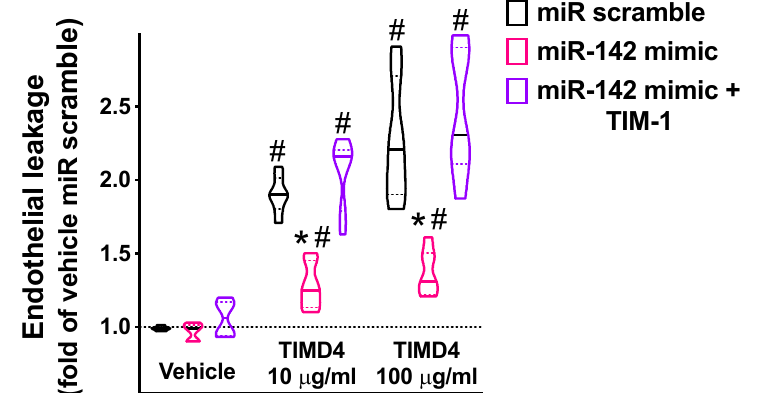
Figure 5. The targeting of TIM ‐ 1 by miR ‐ 142 significantly reduced endothelial permeability. Endothelial leakage triggered by 48 h incubation with TIM ‐ 1 agonist TIMD4 (10 or 100 ng/mL; BioLegend San Diego, CA, USA) was measured in hBMECs transfected with miR ‐ 142 mimic, miR scramble, or by combining miR ‐ 142 mimic and TIM ‐ 1 overexpression ( pcDNA3.1 ‐ TIM ‐ 1 plasmid; GenScript , Piscataway, NJ, USA). All experiments were performed at least in triplicate; in the violin plot, median (solid line) and quartiles (dotted lines) are indicated; * p < 0.01 vs. miR scramble, # p < 0.01 vs. vehicle.